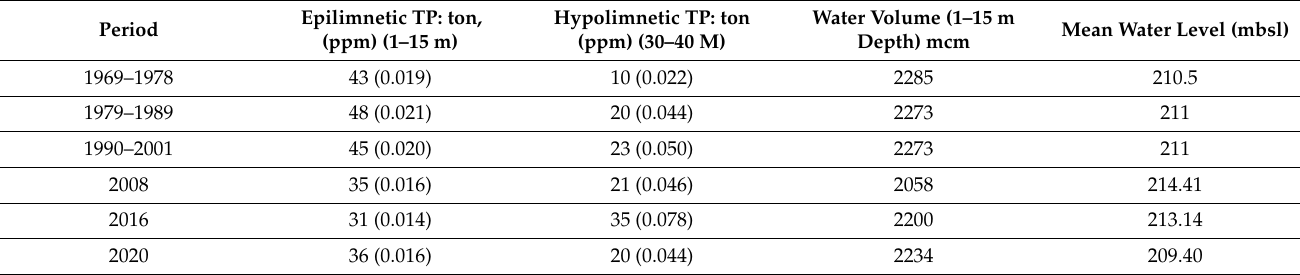
Table 6. Periodical (1969–1978; 1979–1989; 1990–2001) averages of total phosphorus (TP) loads in the epilimnion concentra- tions (ppb) in Lake Kinneret. Analysis of TDP and SRP started from 1974 [21].